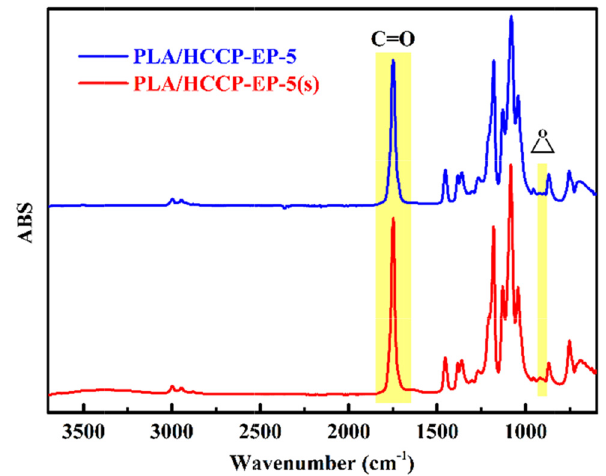
Figure A2: The FT - IR absorbance spectrum of PLA/HCCP - EP - 5 and PLA/HCCP - EP - 5 ( s )